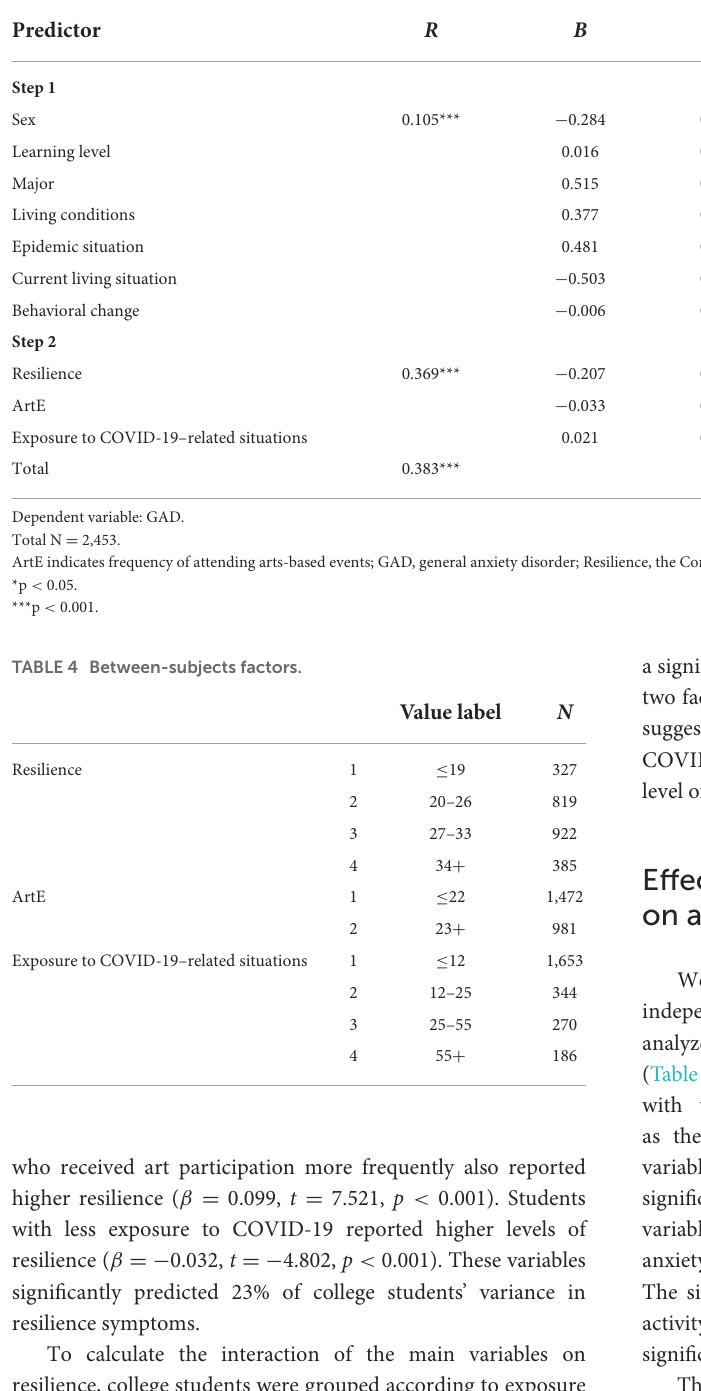
TABLE 3 Hierarchical multiple linear regression for predicting anxiety symptoms.